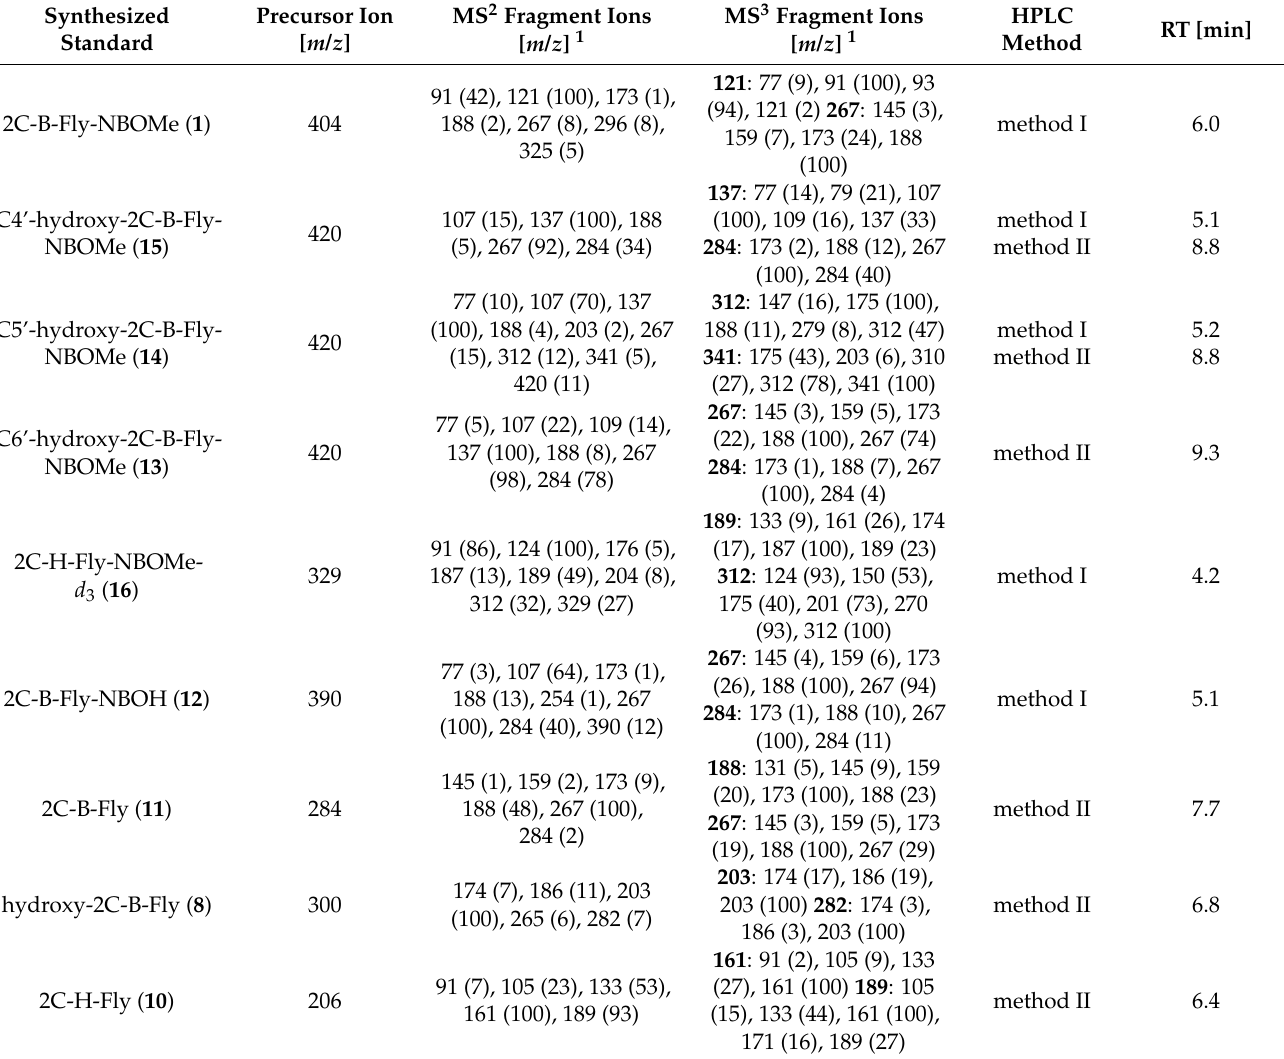
Table 1. 2C-B-Fly-NBOMe and its proposed metabolites: precursor ion masses, characteristic fragment ions in MS 2 and MS 3 scan modes, and retention times (RT). The first order product ions fragmented in linear ion trap are written in bold. Data were acquired by an UltiMate 3000 LC system (Thermo Fisher Scientific, Waltham, MA, USA) combined with a QTrap 6500 mass spectrometer (Sciex).